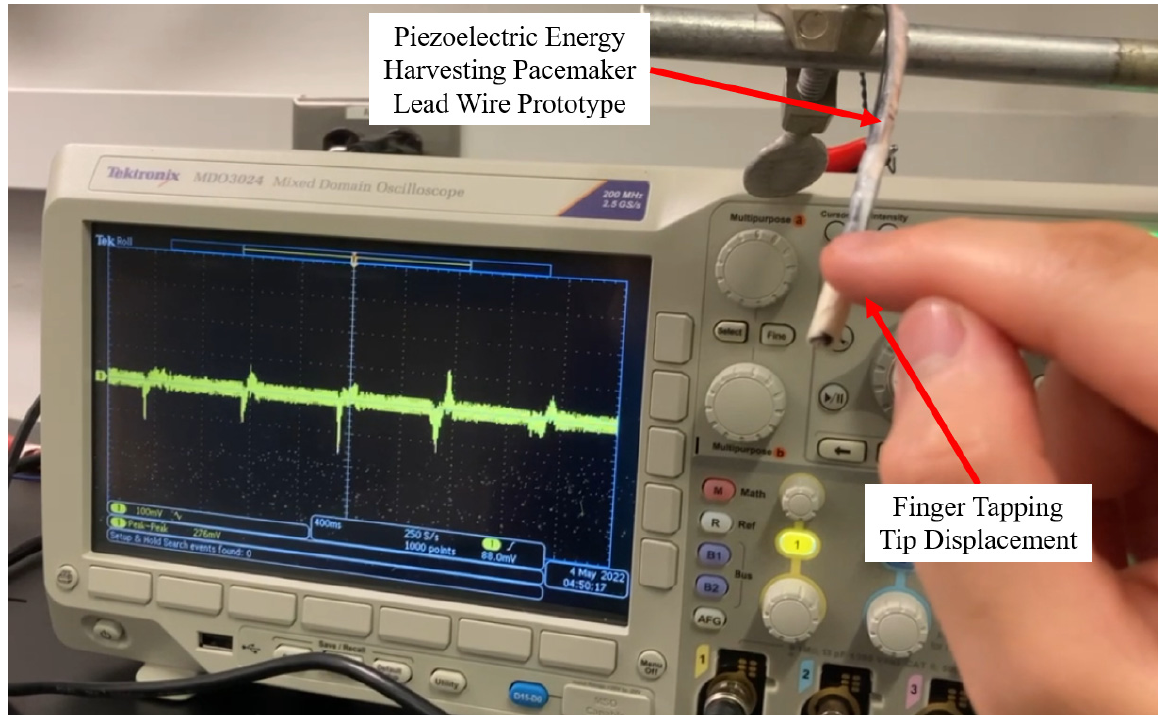
Figure 5. Experimental setup for cantilever tip displacement testing of the assembled piezoelectric energy harvesting pacemaker lead wire prototype.